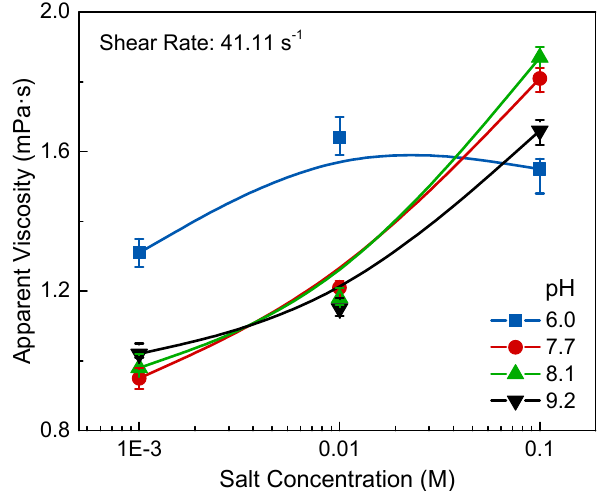
Figure 8. The changes in transmittance of Na-Mt suspensions through the sedimentation process with respect to increasing salt concentration as a function of pH. The test samples were taken from the 30 mL tick mark of the measuring cylinder.